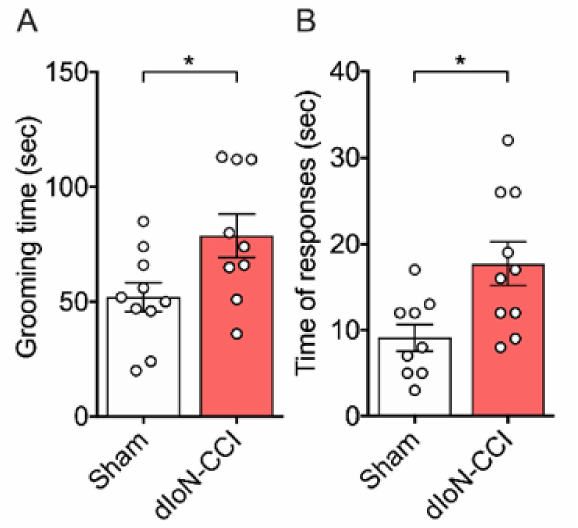
Figure 1. Pain-related behaviors following distal infraorbital nerve chronic constriction injury (dIoN- CCI) in mice. ( A ) Total grooming time in sec. ( n = 9–10/group) and ( B ) total number of responses to acetone ( n = 9–10/group) were assessed 7 and 13 days after the surgery, respectively. Individual data and mean ± SEM are shown. * p < 0.05 compared to sham (unpaired t test).